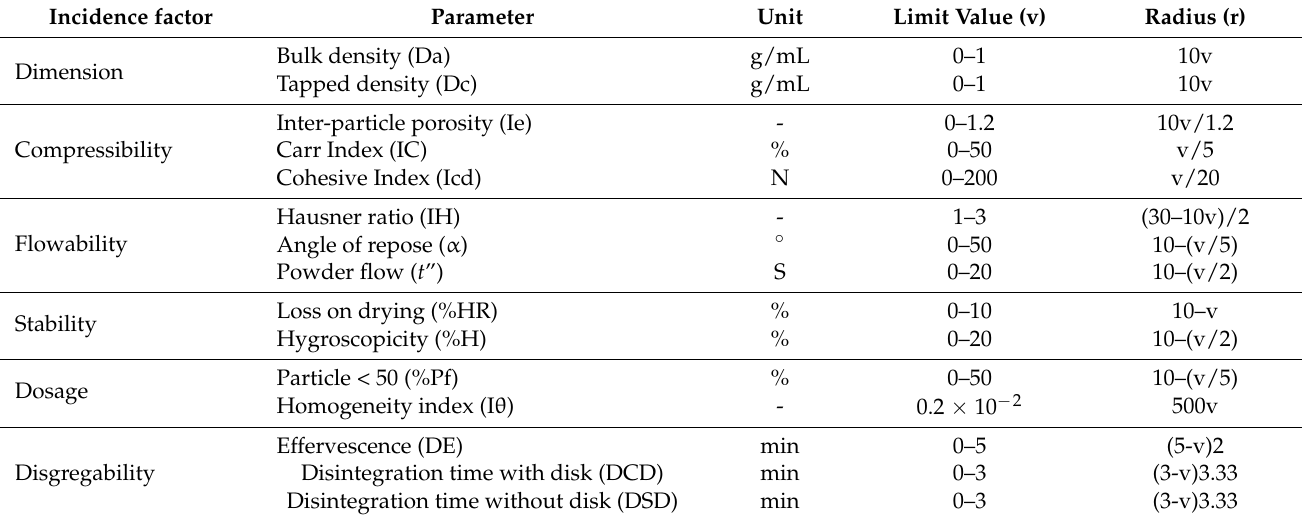
Table 9. Evaluated parameters and conversion of parameter values to radius